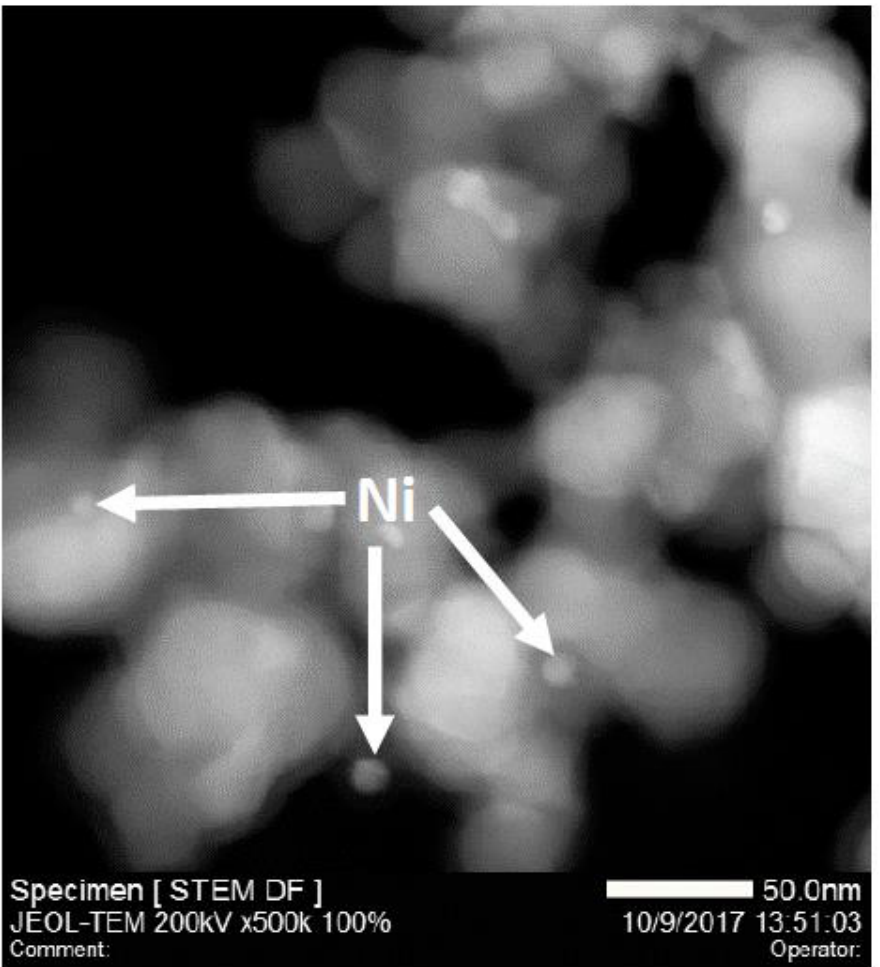
Figure 12. STEM image of the 0.5Ni 1 /HAP-SAC catalyst after reaction at 750 °C.